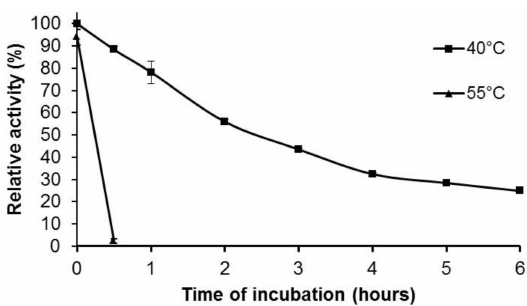
Figure 6. Thermal stability of purified Pc Xyn11A at 40 and 55 ◦ C measured under a standard enzyme assay